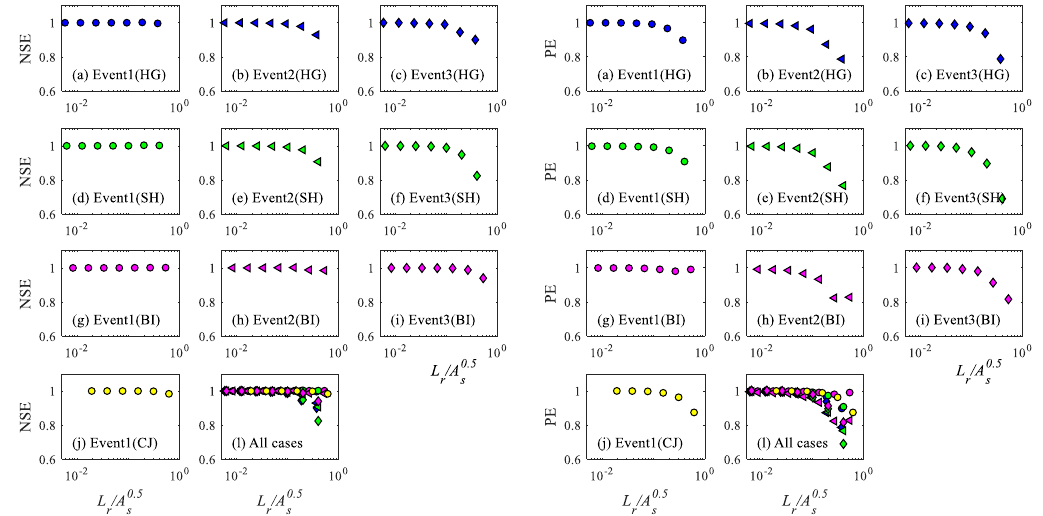
Figure 7. NSE and PE values for runoff predictions with various RSRs with 𝑇 𝑟 = 10 min .